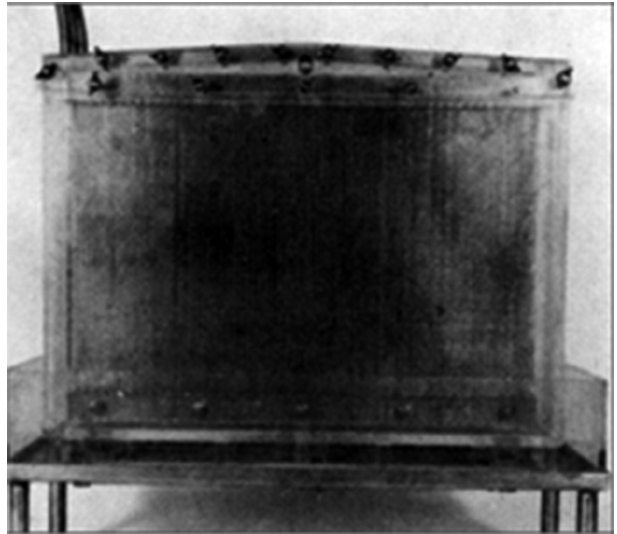
Fig. 2 - Screen oxygenator, 1946. Source: Correa Neto, 1988.